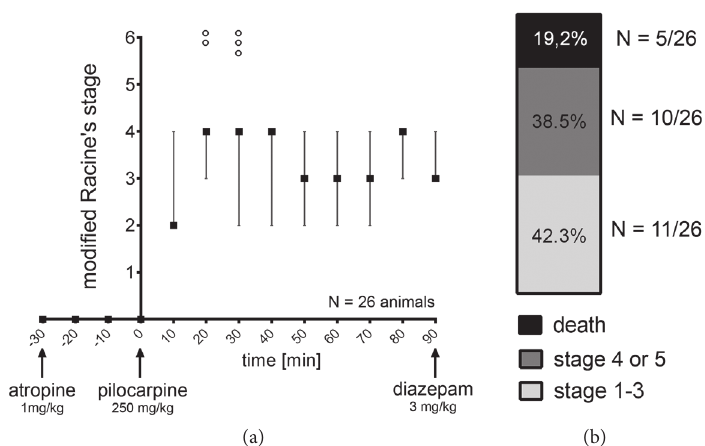
Figure 1: Intraperitoneal pilocarpine injection leads to stable behavioral seizure activity. (a) After a single dose of intraperitoneal pilocarpine injection (250 mg/kg), behavioral seizure activity was documented every 10 minutes using the modified Racine’s stages. Stage 6 animals (indicated by black circles) were not included in the analysis.(stage 0 = no seizures, 1 = freezing, 2 = single twitches, 3 = orofacial seizures, 4 = clonic seizures, 5 = tonic seizures, and 6 = death). (b) 90 minutes after pilocarpine injection 42.3% of the animals were in stages 1–3 and 38.5% were in stage 4 or 5 of the modified Racine’s stages. 5 out of 26 animals died during experimental procedure and were not included in further analysis ( 𝑁 = 26 animals; stages 1–3: 11/26 animals, stage 4 or 5: 10/26 animals, death: 5/26 animals).